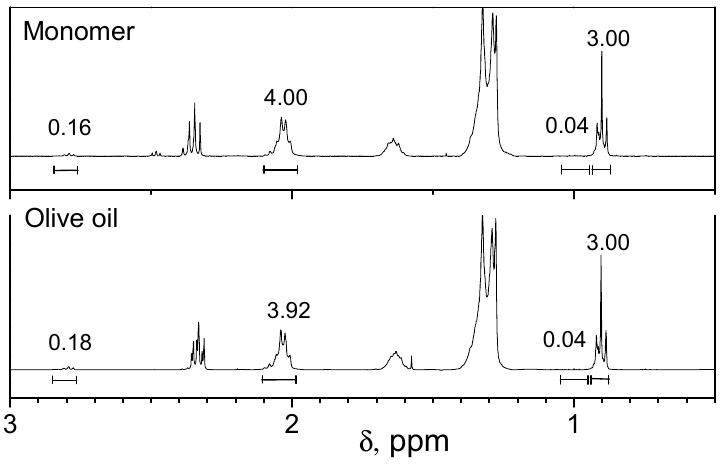
Figure 8. 1 H NMR spectra of the olive oil and the olive oil-based monomer.